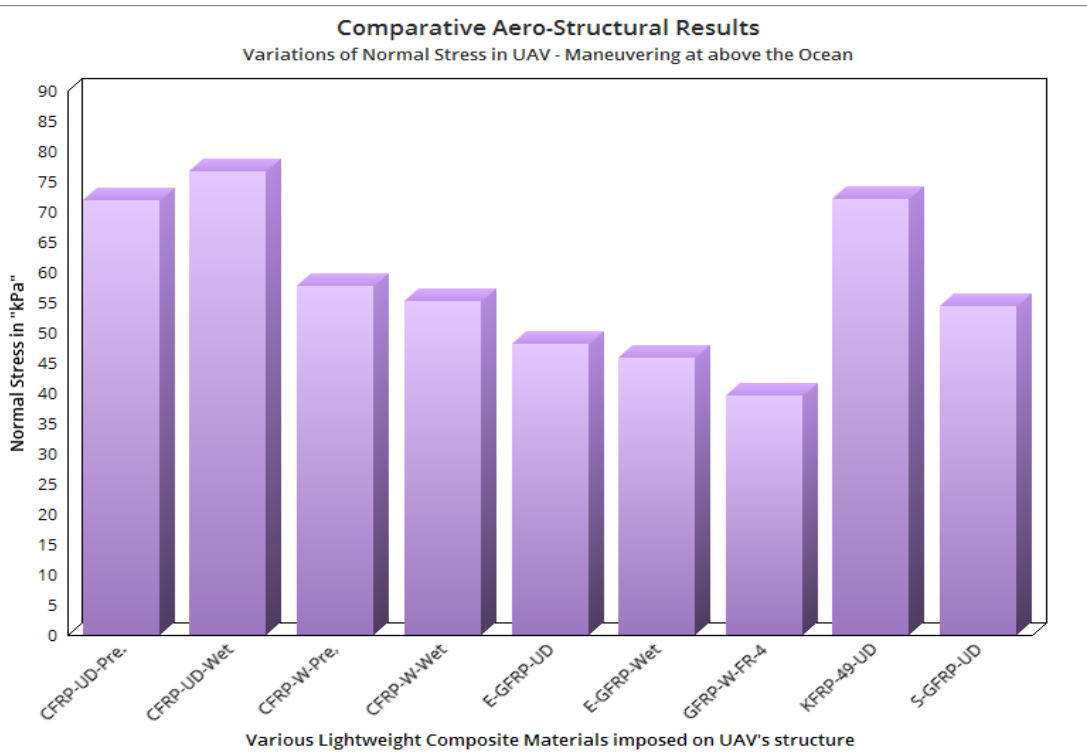
Figure 21. Comparative Normal stress variations for various composites.